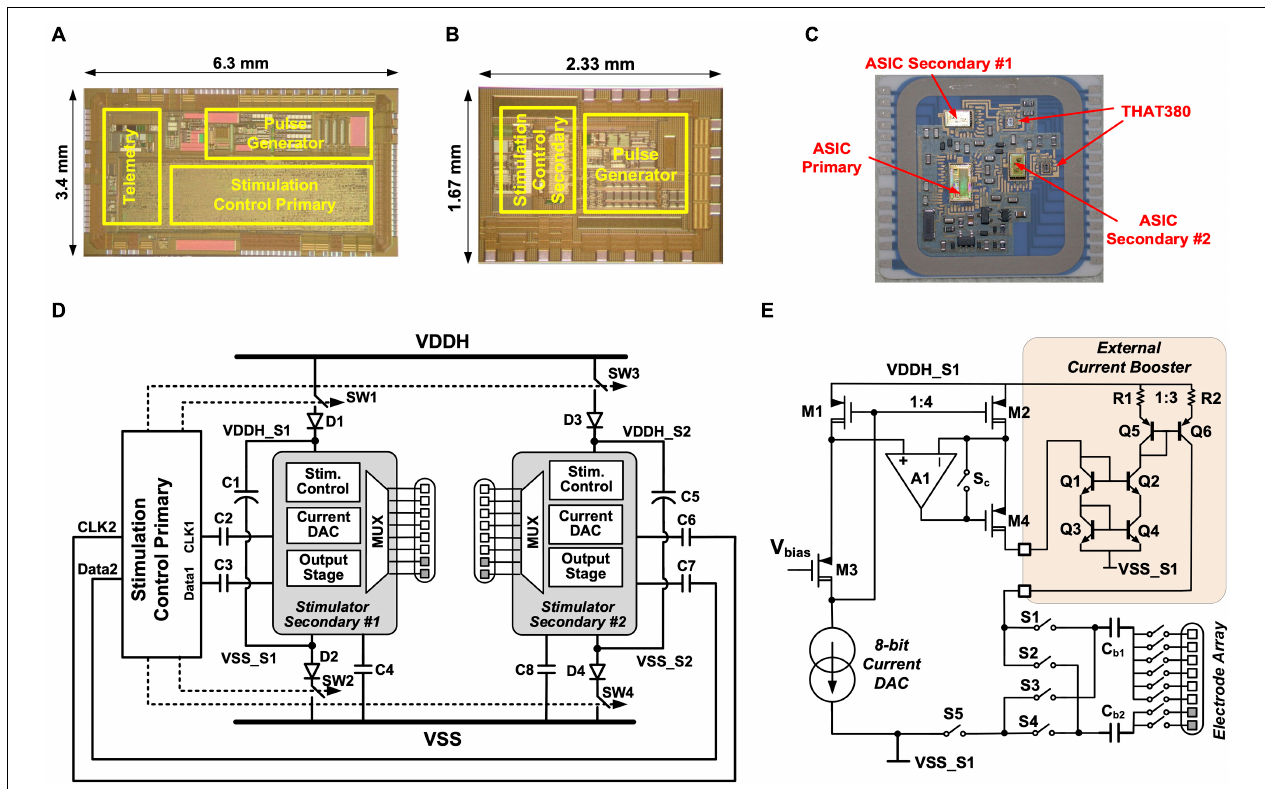
FIGURE 2 | Stimulator circuits: (A) Microphotograph of the primary stimulator ASIC; (B) Microphotograph of the secondary stimulator ASIC; (C) Layout of the stimulator circuits inside the hybrid; (D) Schematic of the power isolation scheme for crosstalk reduction; (E) Integrated pulse generator on Stimulator Secondary #1 (the circuits for the integrated pulse generator on Stimulator Secondary #2 are